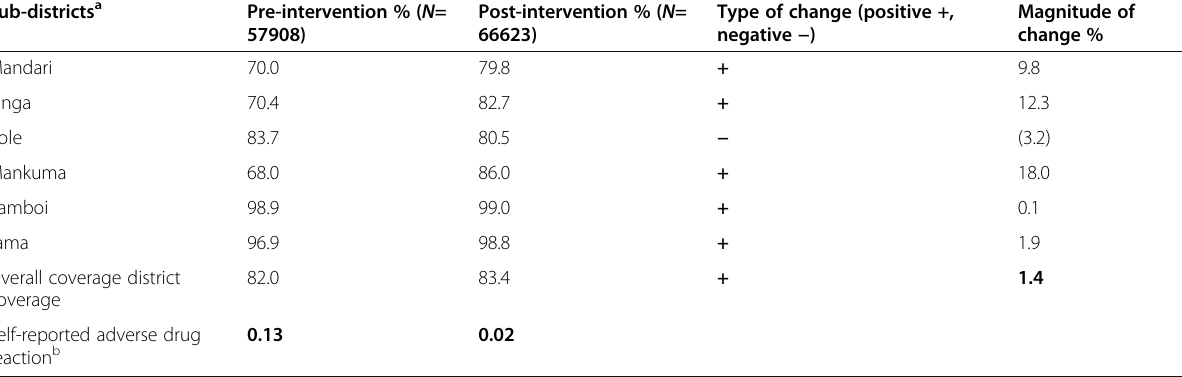
Table 2 Distribution of pre- and post-intervention sub-district MDA coverage among residents in Bole District Sub-districts